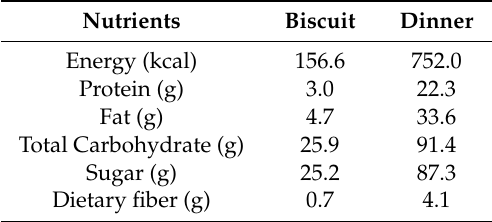
Table 3. Nutrition facts for the biscuit and dinner.